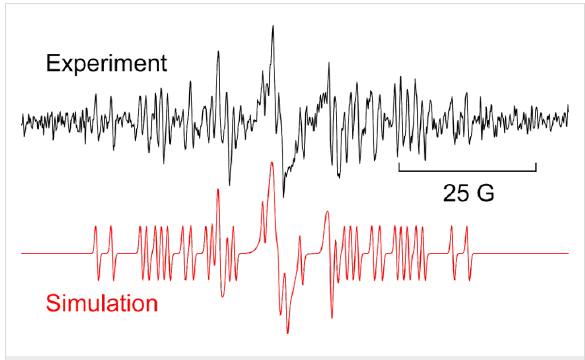
Figure 2: EPR spectrum during photolysis of 1f in t -BuPh at 240 K. Top (black): experimental spectrum. Bottom (red): computer